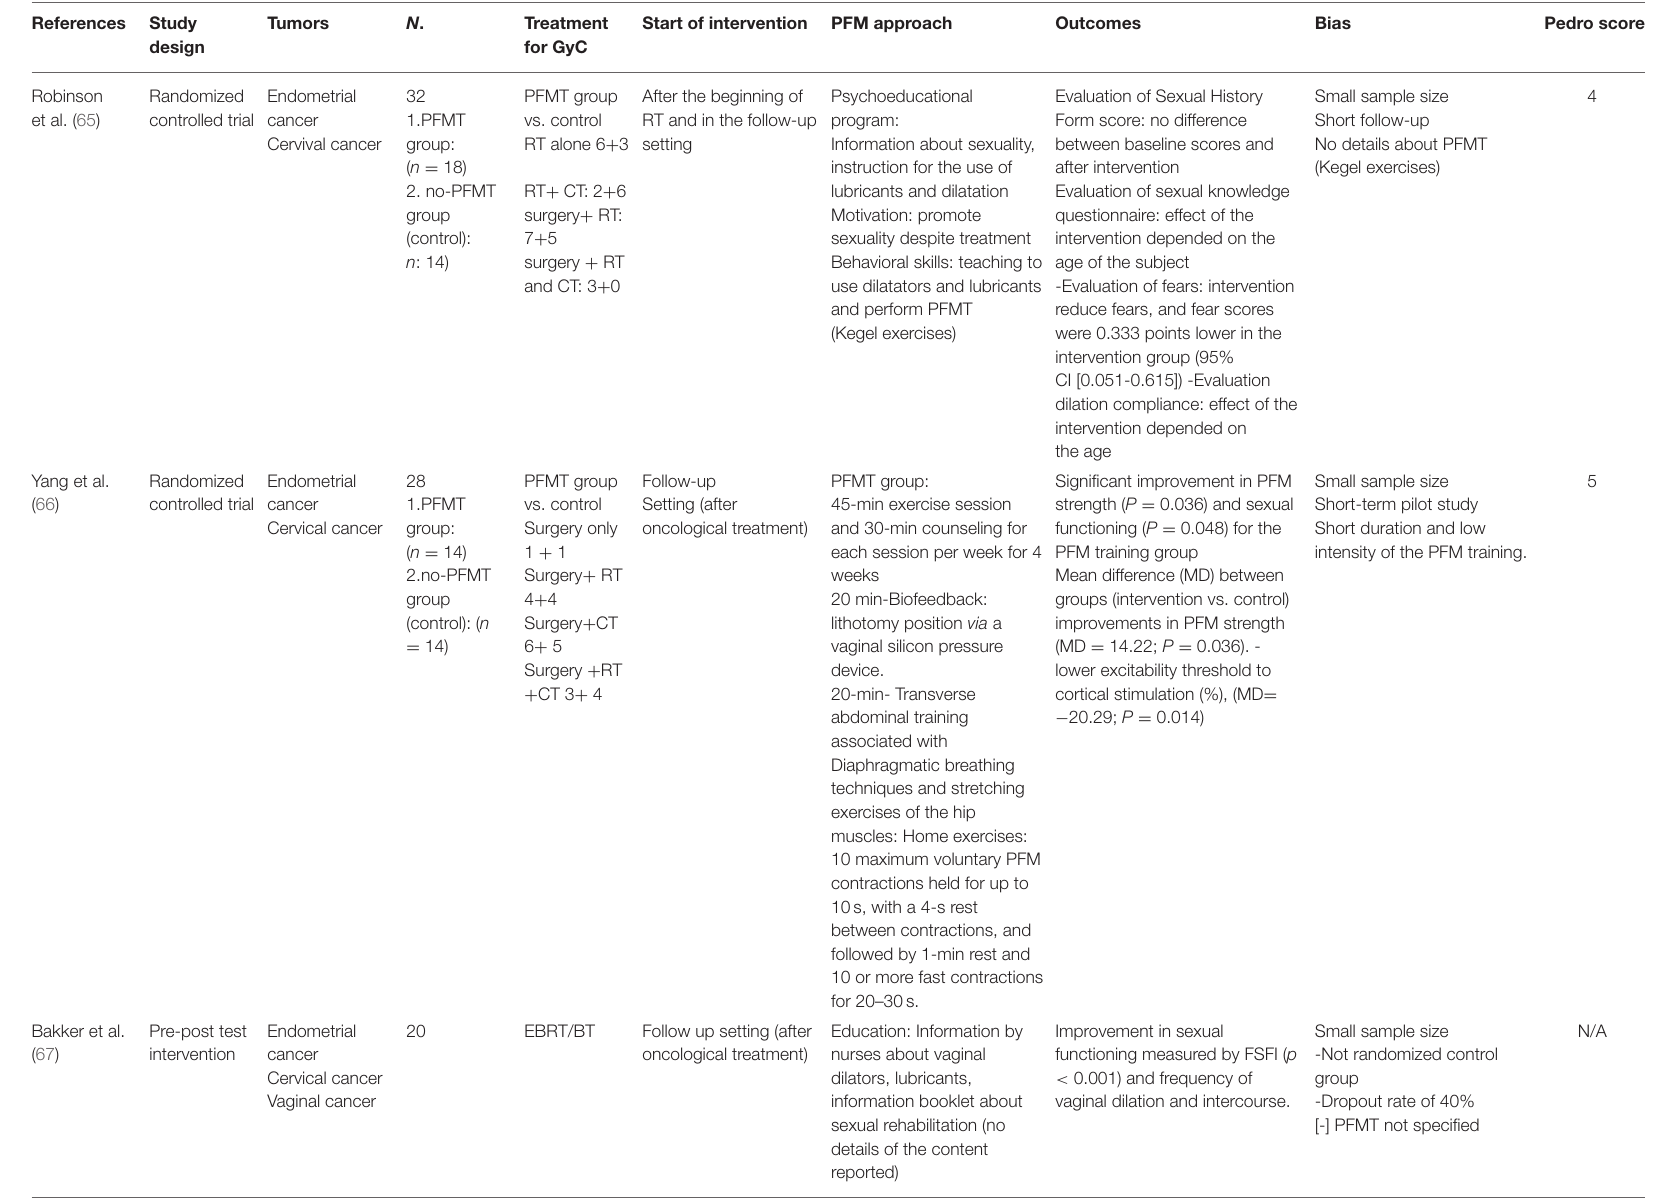
TABLE 3 | Pelvic floor muscle training (PFMT) alone or in combination with other treatments for sexual dysfunction in gynecological cancer (GyC) patients. References Study